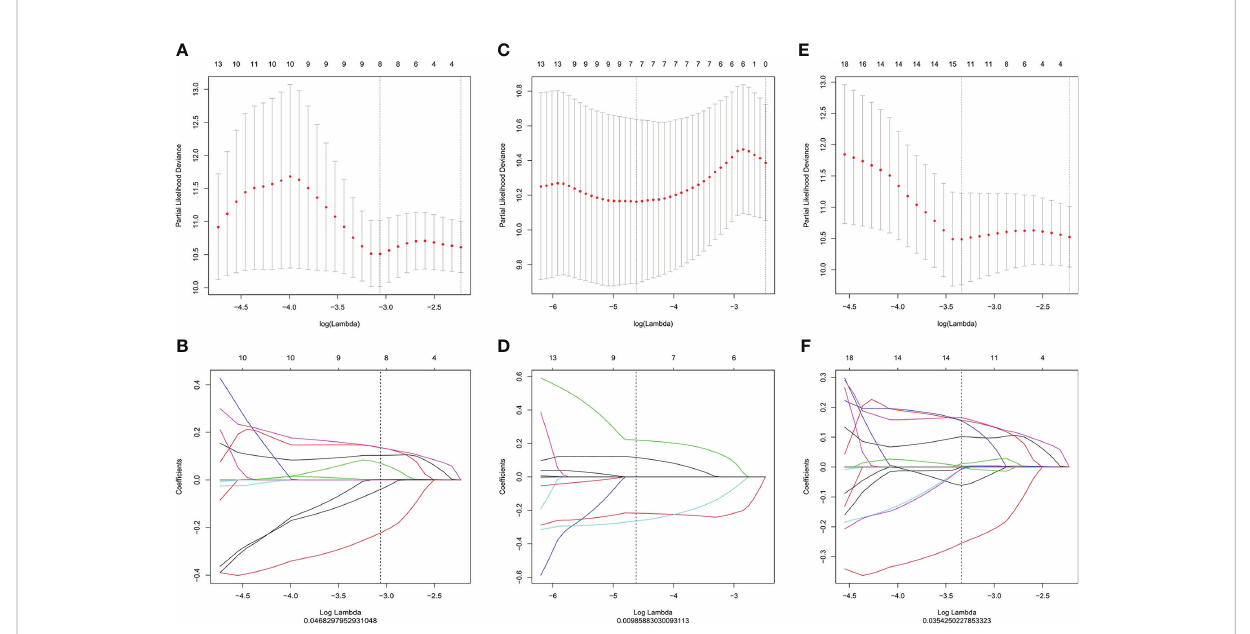
FIGURE 2 LASSO regression for radiomic feature selection in K trans (A, B) , V e images (C, D) and K trans + V e images (E, F) . (A, C, E) Selection of the optimal value of lambda ( l ). Tuning log( l ) selection in the LASSO model used to perform 10-fold cross-validation via the minimum criteria. The y-axis indicates the partial likelihood deviance, while the lower x-axis indicates the log ( l ) and the upper x-axis represents the average number of predictors. (B) , (D) , (F) : Each colored curve represents the trajectory of the change of an independent variable. Lambda values of 0.04682979 (B) ,